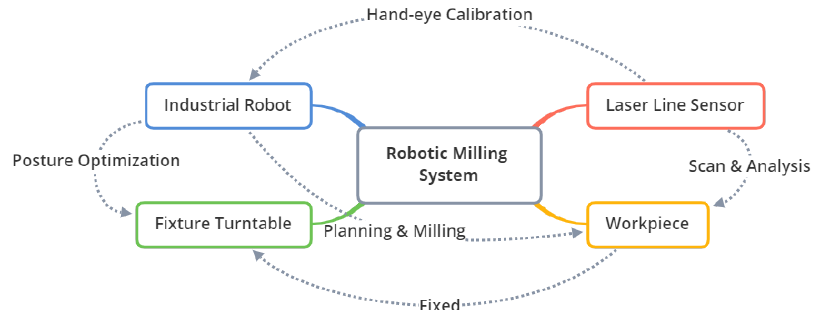
Figure 1. A flexible robotic milling process